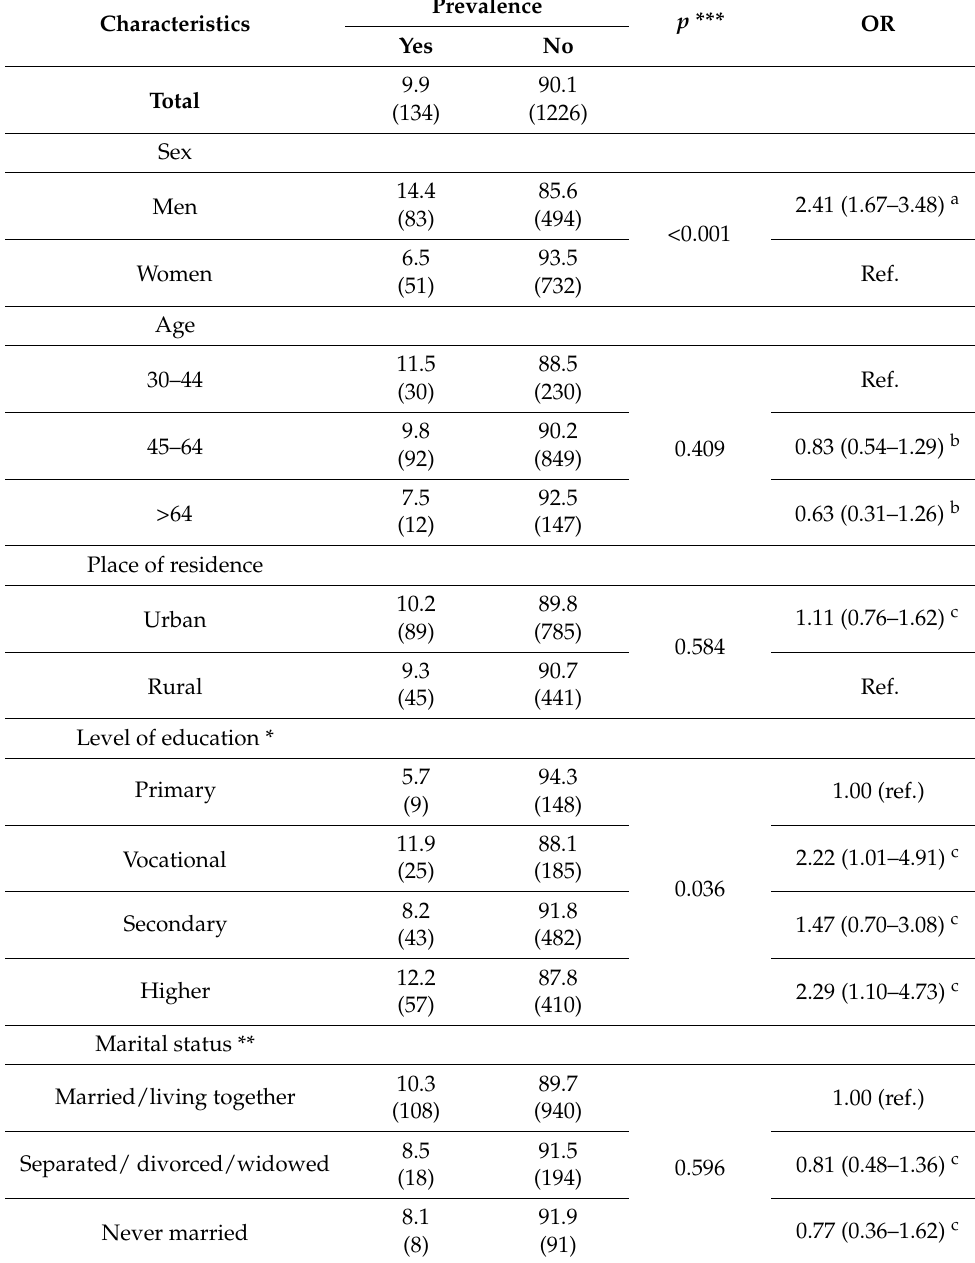
Table 3. The baseline prevalence of heavy episodic drinking among participants who declared current use of alcohol